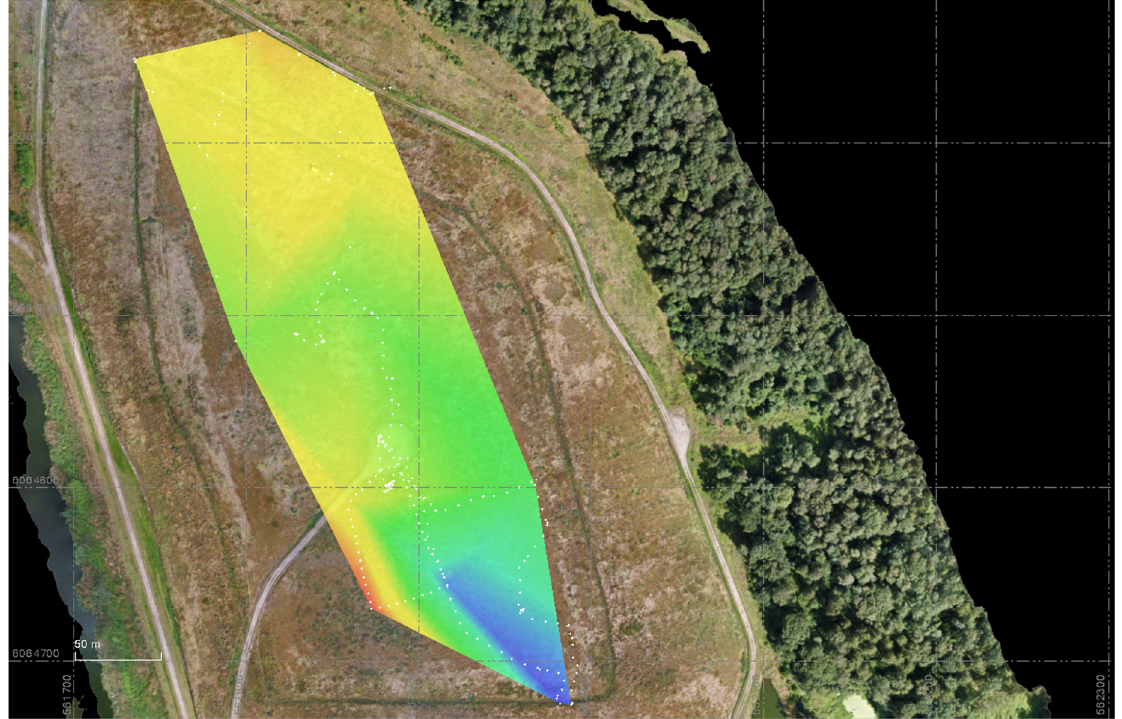
Figure 13. Gas sensor data of experimental studies conducted with the MQ4 sensor in the Kariotiskes landfill site.